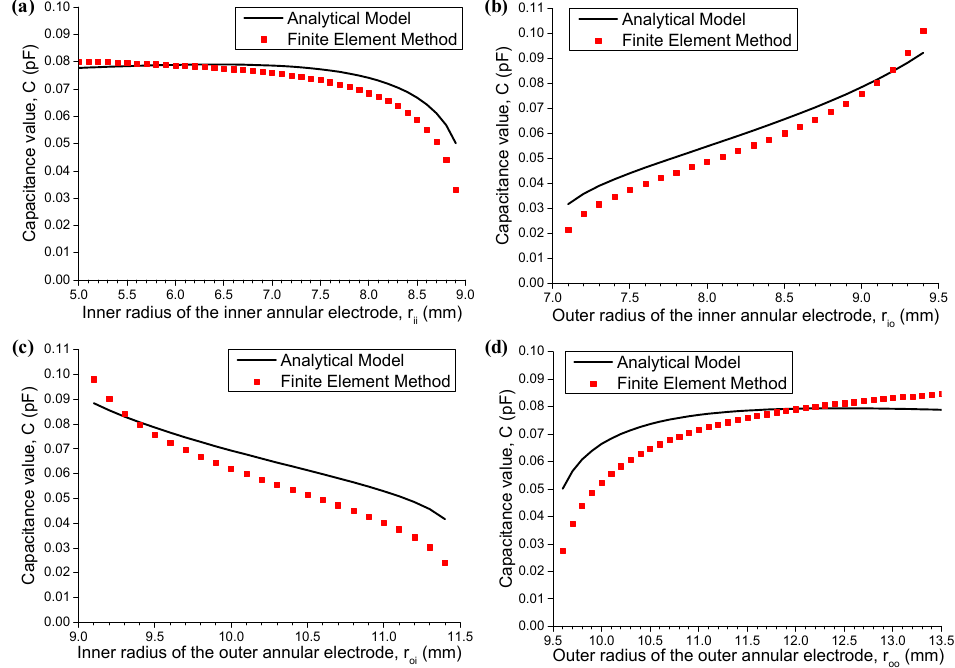
Figure 5. Capacitance values of the capacitors with different parameters in the radial direction: ( a ) r io = 9 mm, r oi = 9.5 mm, and r oo = 11.5 mm, ( b ) r ii = 7 mm, r oi =9.5 mm, and r oo = 11.5 mm, ( c ) r ii = 7 mm, r io = 9 mm, and r oo = 11.5 mm, and ( d ) r ii = 7 mm, r io = 9 mm, and r oi = 9.5 mm.